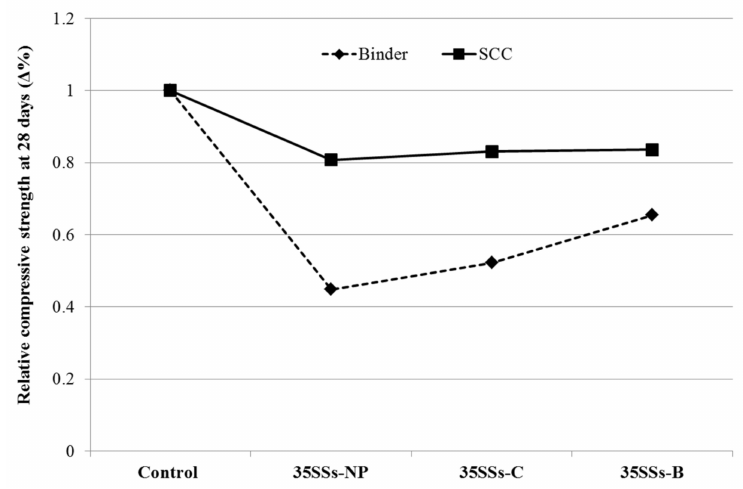
Figure 6. Relative compressive strength of binder and SCC at 28 days versus